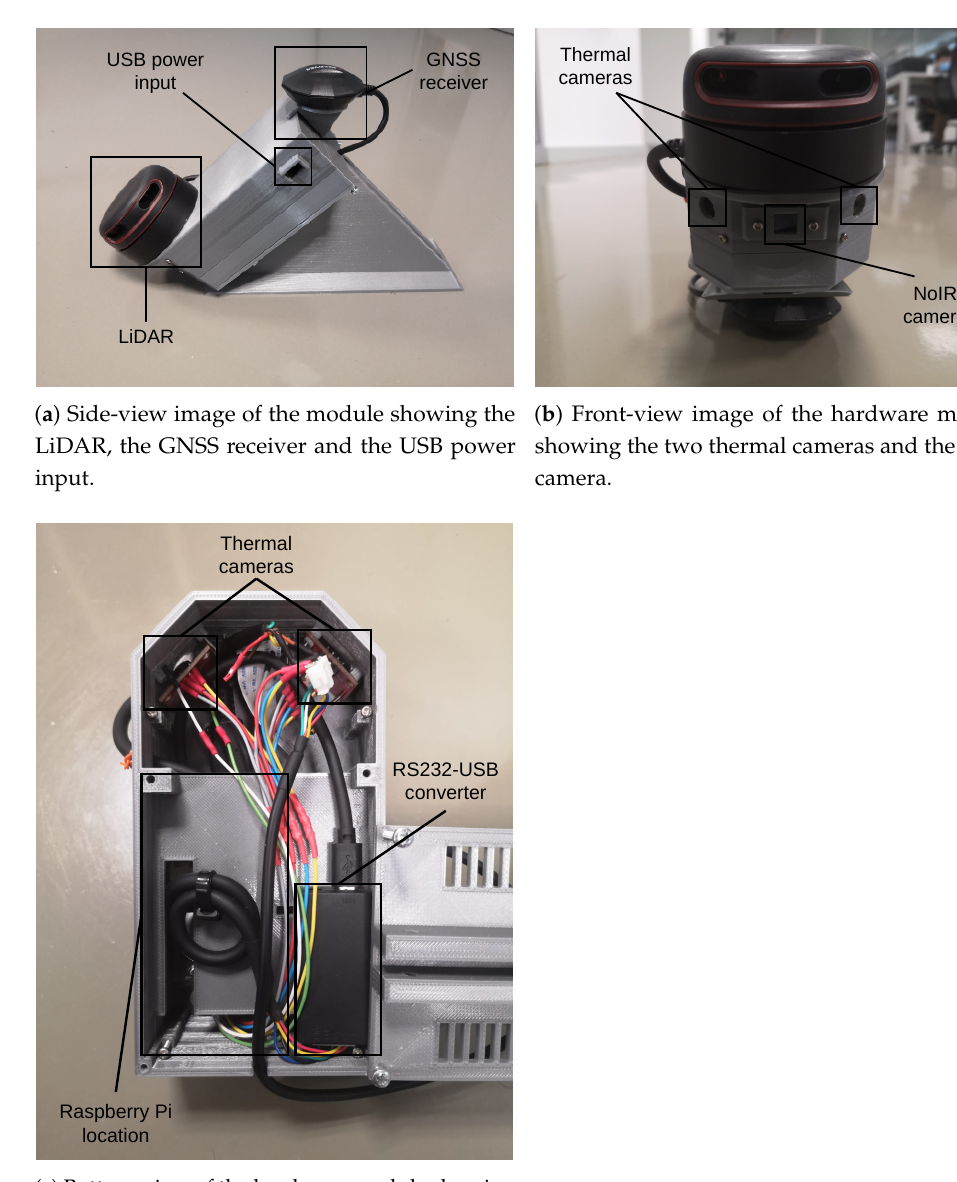
Figure 1. The hardware module: ( a ) side-view, ( b ) front-view and ( c ) bottom-view showing the interior of the module